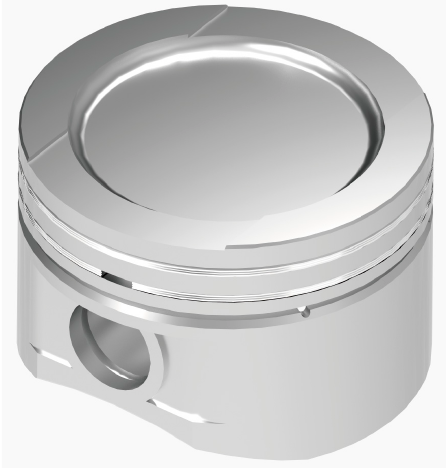
Figure 2. Piston ring group and piston assembly model.